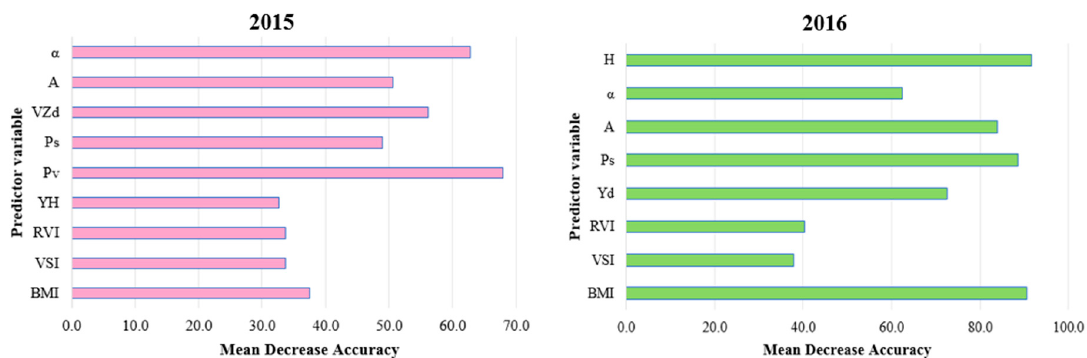
Figure 6. Random Forest’s predictor variables importance measures: mean decrease accuracy for LULC classes for 2015 and 2016. Details of the SAR derived attributes are presented in Table 3.